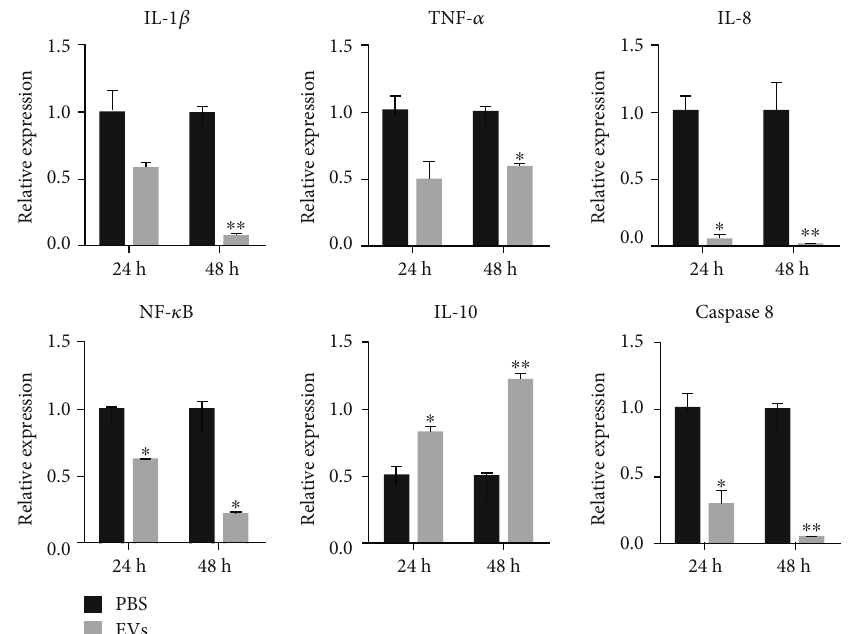
Figure 4: RNA expression level of the immune-related gene in vitro . qRT-PCR revealed that mRNA levels of IL-1 β , IL-8, TNF- α , and NF- κ B in HCEs were highly decreased after treatment with EVs, while anti-in fl ammatory factor IL-10 was increased in vitro . In addition, the EV group signi fi cantly reduced apoptosis-related gene caspase 8 expression compared with the control groups. All data were shown as means ± SEM in triplicate assays. ∗ P < 0 : 05 , ∗∗ P < 0 : 01 versus PBS.